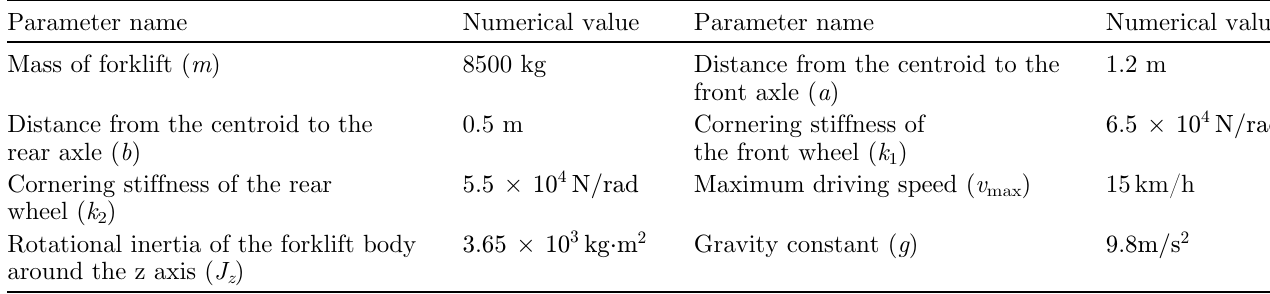
Table 1. Basic simulation parameters of the forklift model.